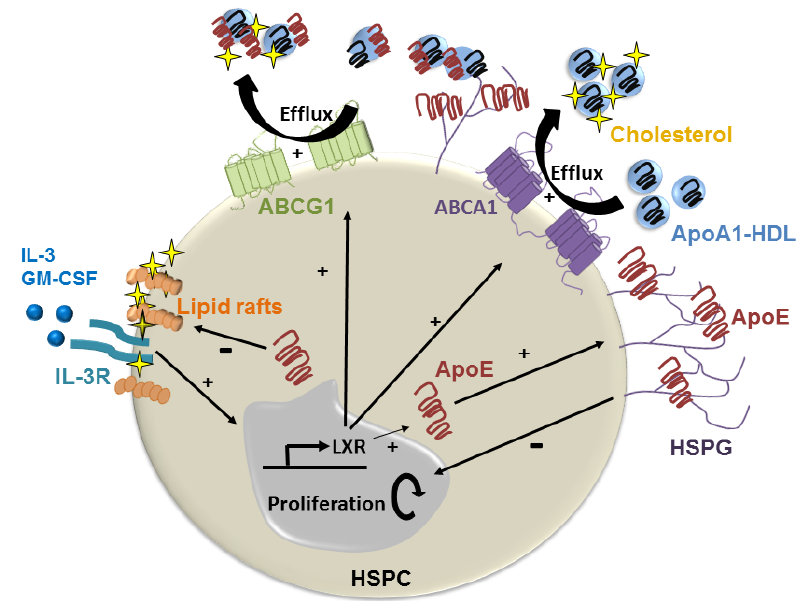
Figure 2. ApoE suppression of lipid-induced HSPC hyperproliferation. Hyperlipidemia promotes HSPC proliferation by enriching the plasma membrane with cholesterol-rich lipid rafts and the IL-3/GM-CSF receptor to drive growth signaling. ApoE produced by HSPC can become anchored to the cell membrane via HSPG where it promotes cholesterol efflux via HDL containing apoA1 via ABCA-1 and ABCG-1. This reduces cell surface lipid rafts, and thereby growth signaling. HDL containing apoE could also suppress HSPC proliferation by promoting cholesterol efflux via ABCG-1.